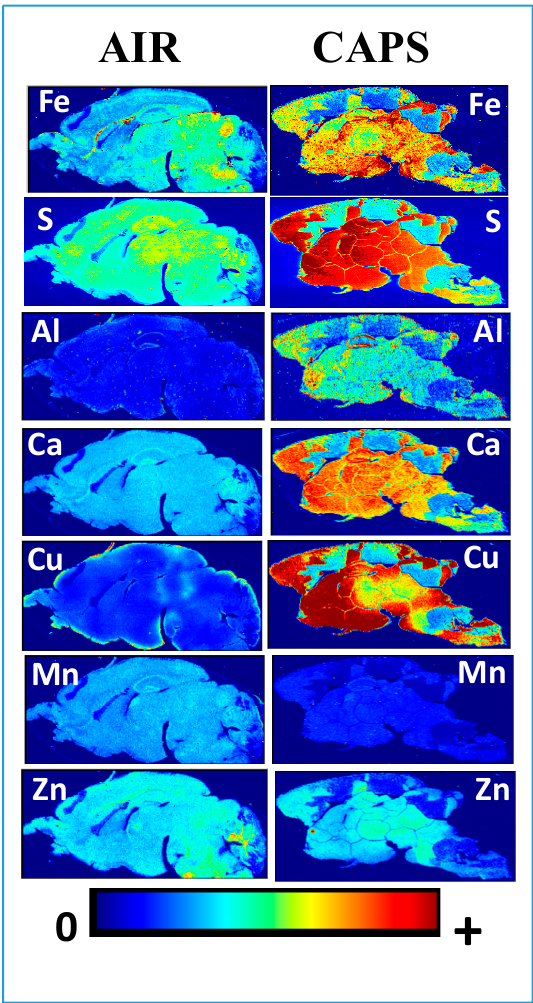
Figure 3. Sagittal brain sections representative postnatal air ( left ) vs. UFP-exposed ( right ) males depicting metals as indicated and analyzed by ICP-MS. Modified from Cory-Slechta et al., 2019 [92].